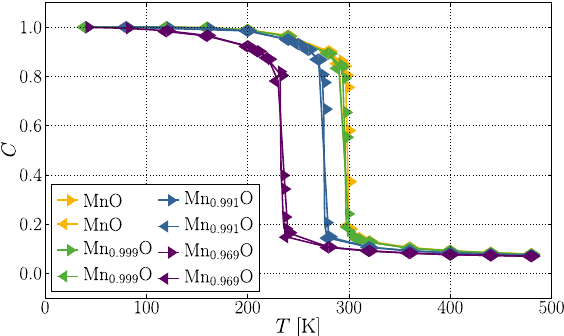
Fig. 6 Impact of Mn vacancies on the temperature dependence of the order parameter. Order parameter C as a function of the temperature T obtained in MDMC simulations for 6 × 6 × 6 supercells of MnO, Mn 0.999 O, Mn 0.991 O, and Mn 0.969 O.